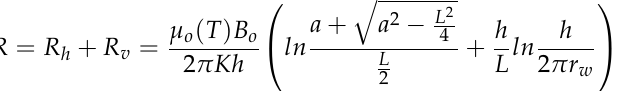
Since the viscosity of crude oil is a function of temperature [22],